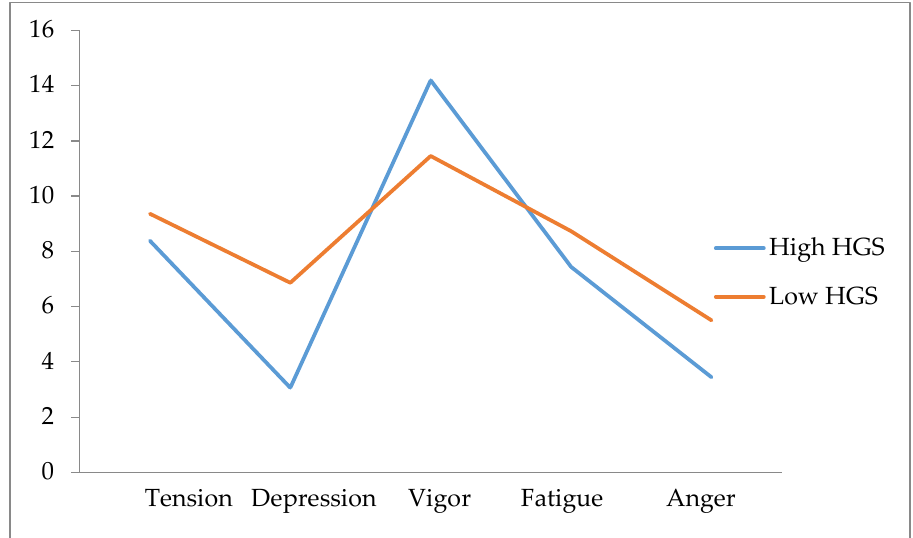
Figure 2. Profile of mood in high HGS and low HGS group.